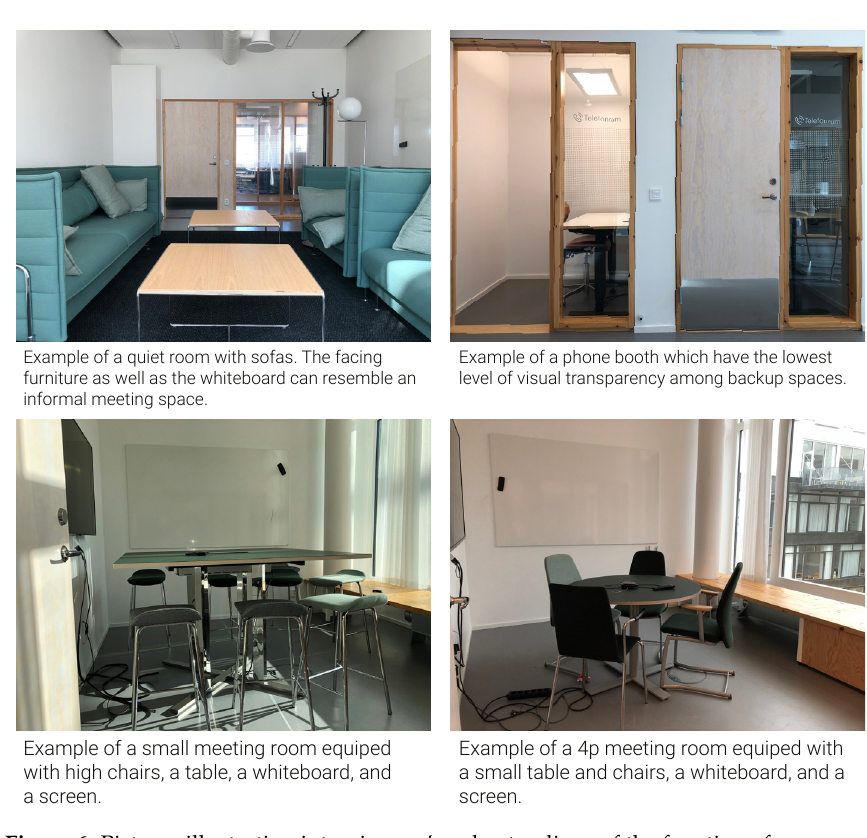
Figure 6. Pictures illustrating interviewees’ understandings of the function of